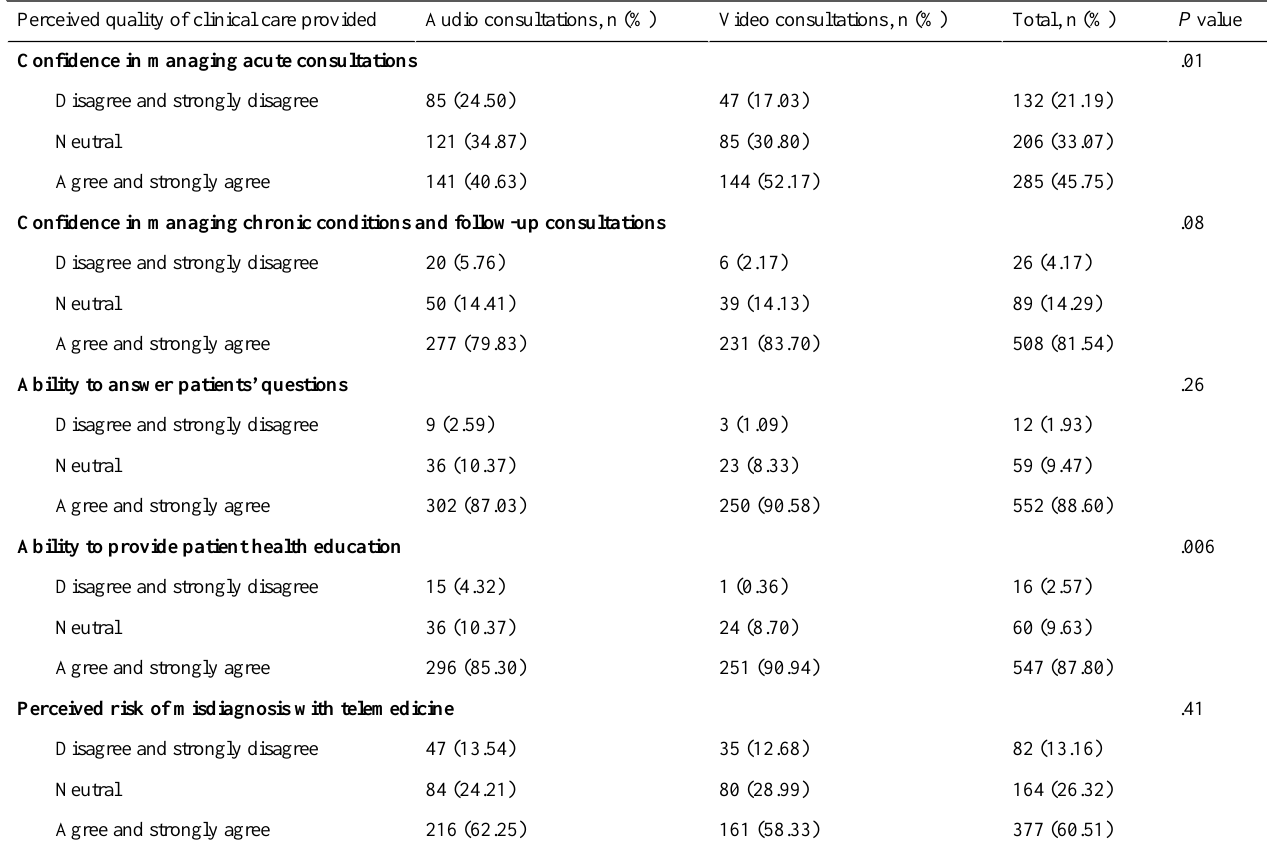
Table 2. Comparison of survey responses on the perceived quality of clinical care provided by modality.